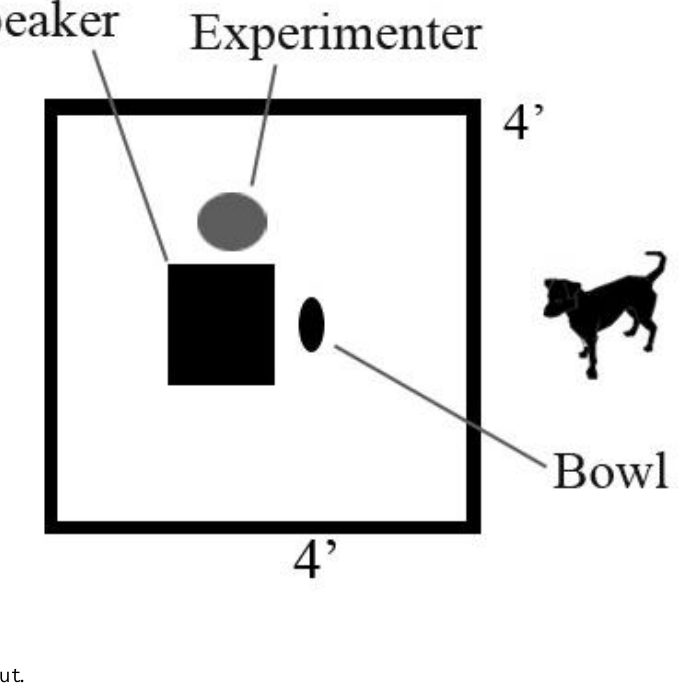
Figure1. Experimental